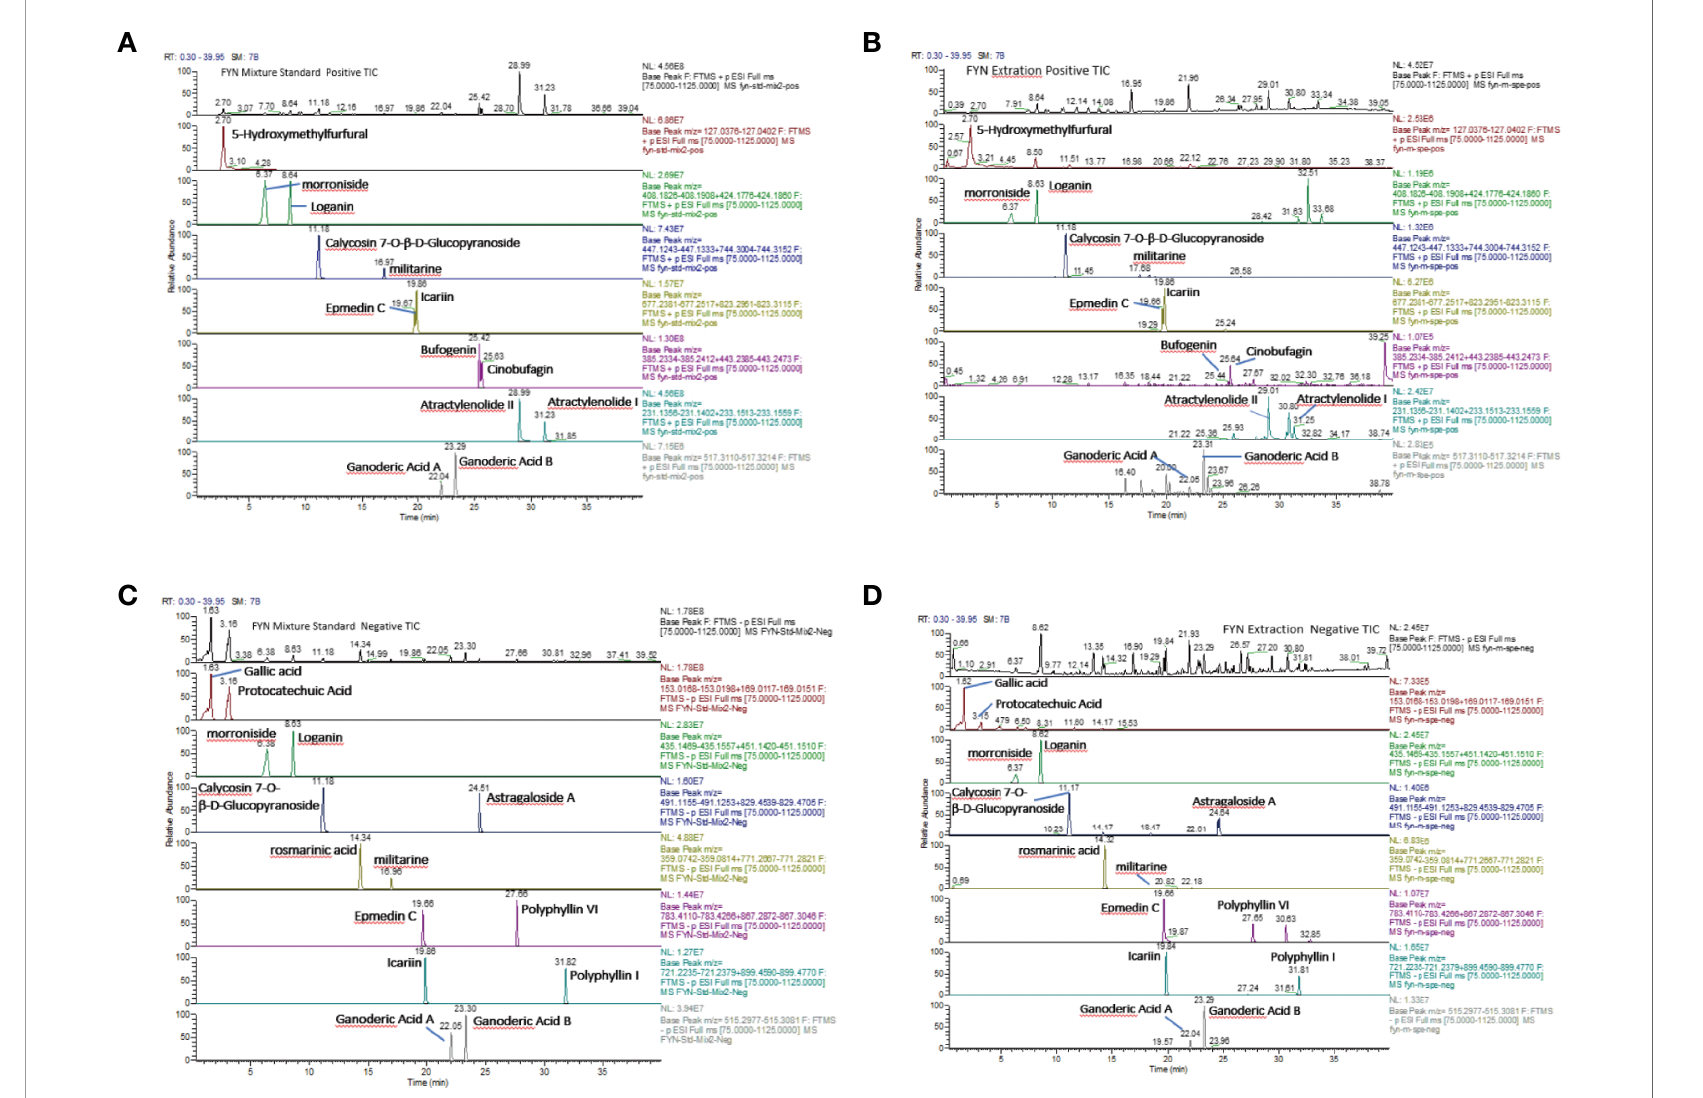
FIGURE 4 | Analysis of FYN by high resolution mass spectrometry. (A) Positive total-ion chromatograms of standard by Waters Acquity UPLC-Thermo Q/Exactive HRMS with the mixture standard solution. (B) Positive total-ion chromatograms of standard by Waters Acquity UPLC-Thermo Q/Exactive HRMS with FYN extract solution. (C) Negative total-ion chromatograms of standard by Waters Acquity UPLC-Thermo Q/Exactive HRMS with the mixture standard solution. (D) Negative total-ion chromatograms of standard by Waters Acquity UPLC-Thermo Q/Exactive HRMS with the FYN extract